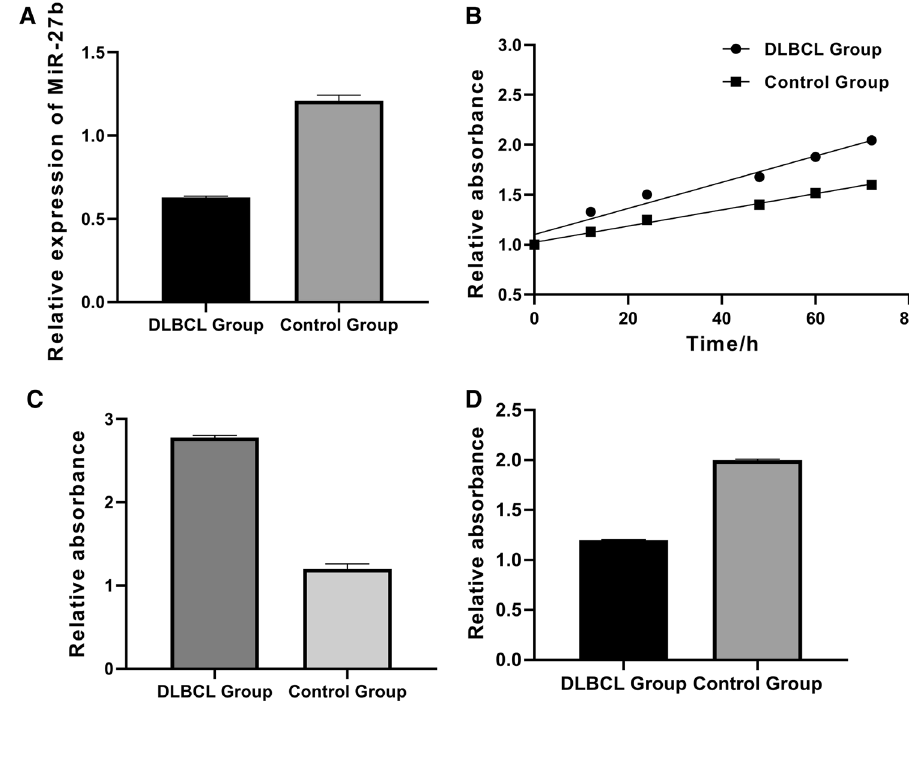
Fig. 3 High expression of miR-27b inhibits the activity of DLBCL cells. A : miR-27b expression levels in two or three groups were deter- mined by qRT-PCR, and miR-27b expression increased in the miR-27b mimics group (P < 0.05); B : The prolifera- tion of the three groups was